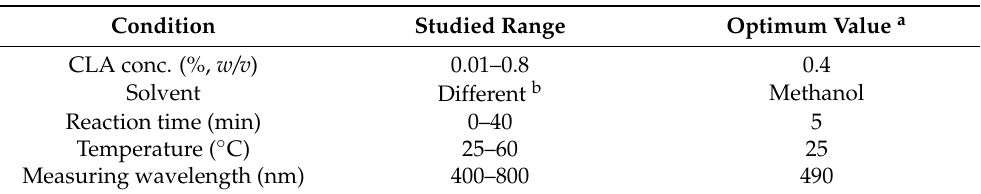
Figure 6. Energy-minimized CTC of CLA with OLA in the conformational ( A ) and 3D structures ( B ).